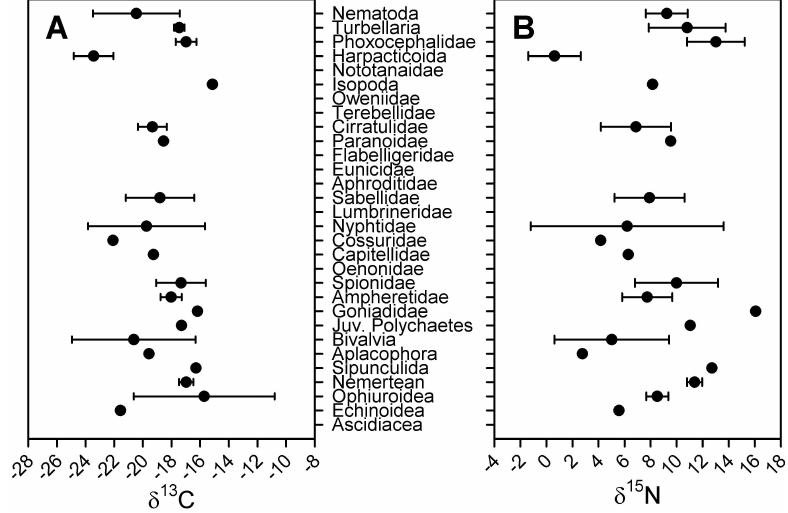
Fig. 4. Natural Stable-Isotopic signatures of macrofauna at the Indian continental margin. Data are means ( ± standard deviations) from a series of 13 push cores taken between 800 and 1000m, by Shinkai 6500 during YK08-11.